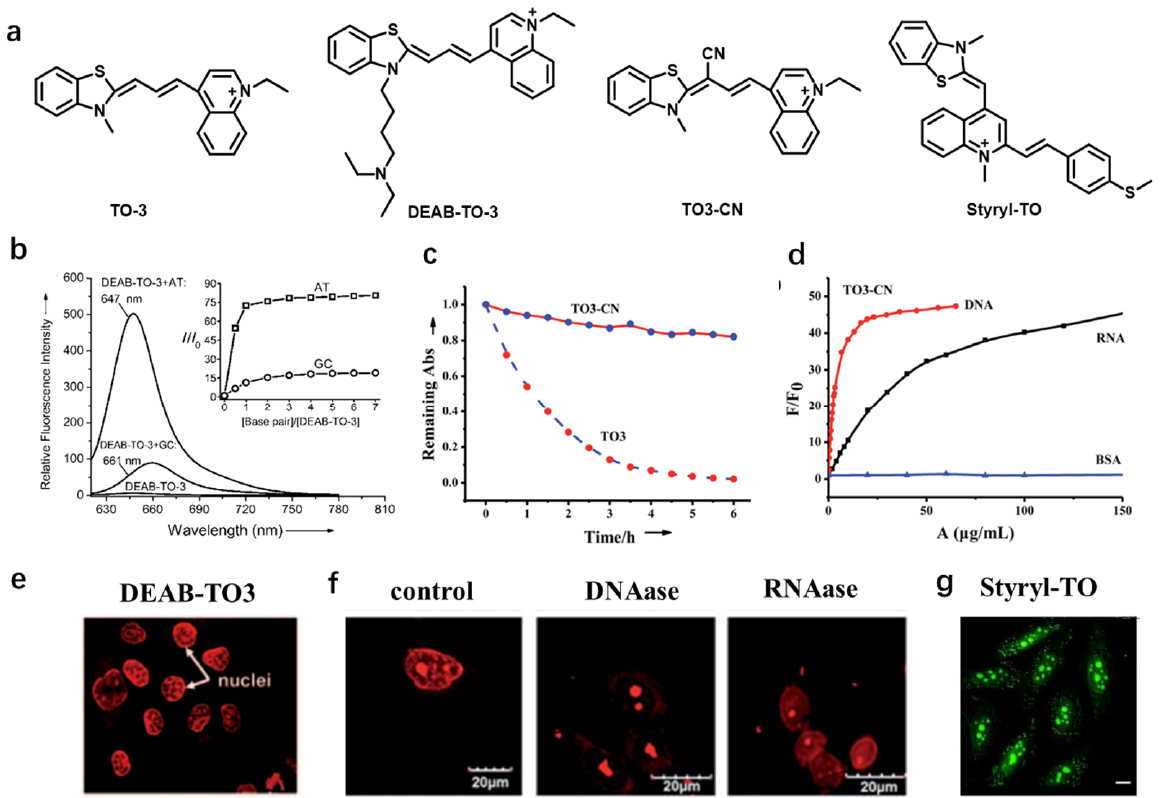
Figure 7. ( a ) Structures of TO-3, DEAB-TO-3, TO3-CN and Styryl-TO. ( b ) Fluorescence emission spectra and enhancement of fluorescence intensities during the titration of a solution of DEAB-TO-3 (1 μM) with poly(dA-dT) 2 and poly(dG-dC) 2 at 20 °C. Inset: The [base pair]/[DEAB-TO-3] molar ratios are from 0.5 to 7. ( c ) Photostability response of probes TO3-CN. ( d ) Fluorescence response of TO3-CN (1 mM) to DNA, RNA and bovine serum albumin (BSA). ( e ) Fluorescence images of DEAB- TO-3 treated live HeLa cells at 5 mM concentration. Reproduced from Ref. [29] with permission from John Wiley and Sons, Copyright 2011. ( f ) DNase and RNase digest experiments with TO3-CN in MCF7. TO3-CN (excited at 559 nm and collected at 575 nm to 620 nm) was cultured at 2 mM for 45 min. Reproduced from [30] with permission from the Royal Society of Chemistry, Copyright 2014. ( g ) Fluorescence images of Styryl-TO. Reproduced from [31] with permission from the Royal Society of Chemistry, Copyright 2015.